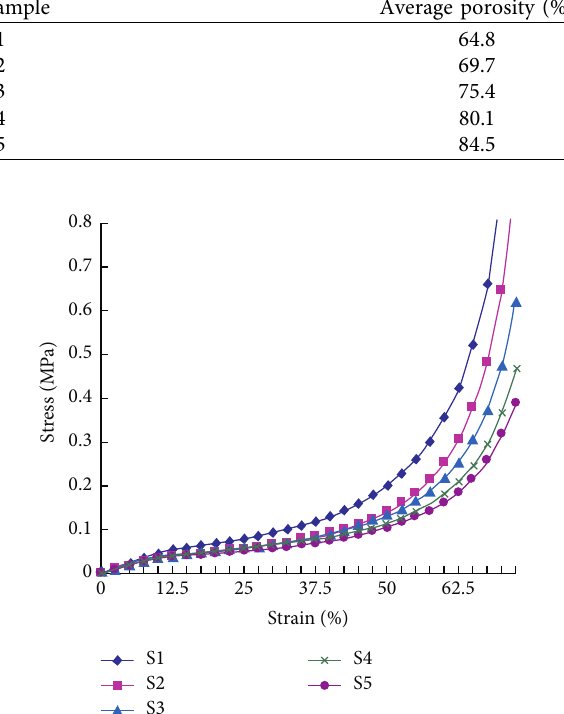
Table 1: Data of void fraction of different samples. Sample